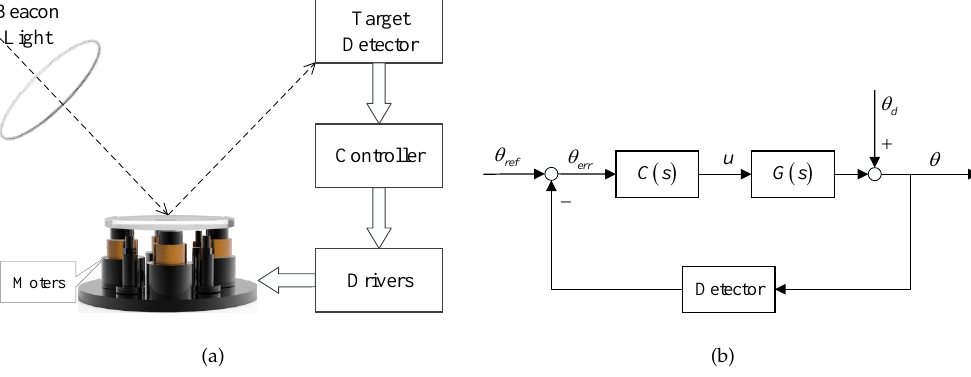
Figure 1. The schematic of the tip-tilt mirror control system: ( a ) structure diagram. ( b ) block